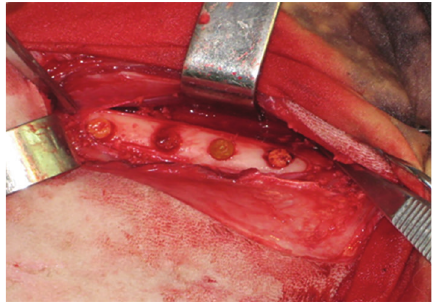
Figure 4: 4 weeks after implanting n-HA/PA66